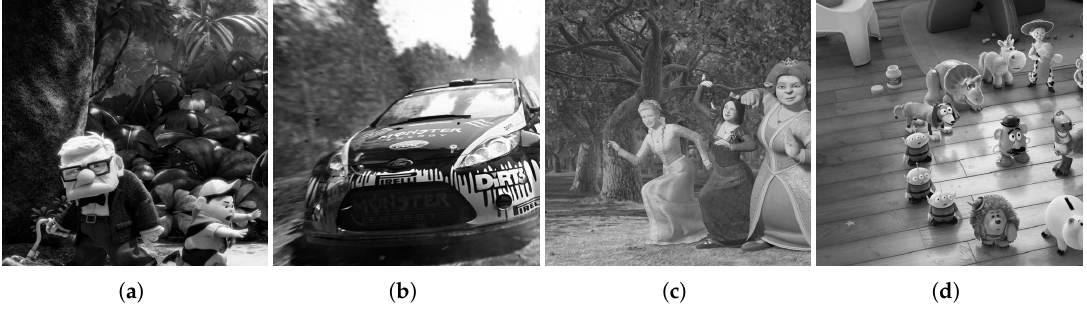
Figure 5. ( a – d ) The 4 imagesin the ESPL